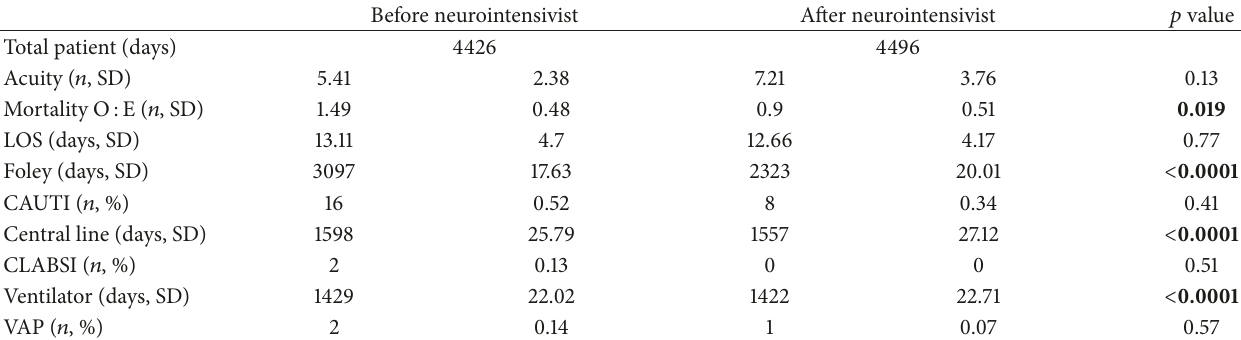
Table 2: Quality metric data.